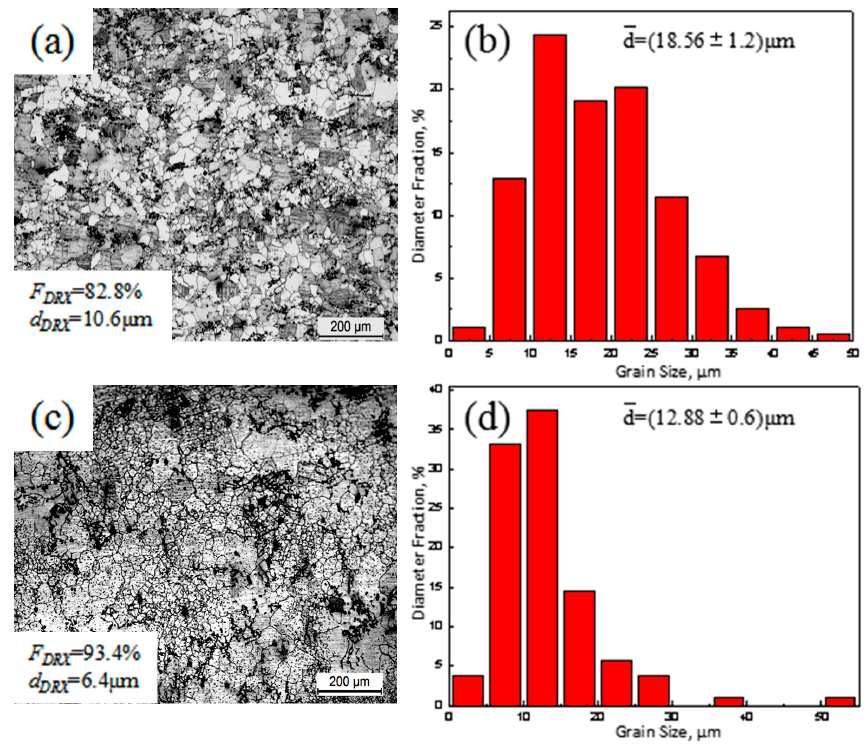
Figure 3. Optical micrographs and grain size distribution of ECAPed Mg-9Al-1Si-1SiC composites: ( a , b ) without HT; ( c , d ) with HT.